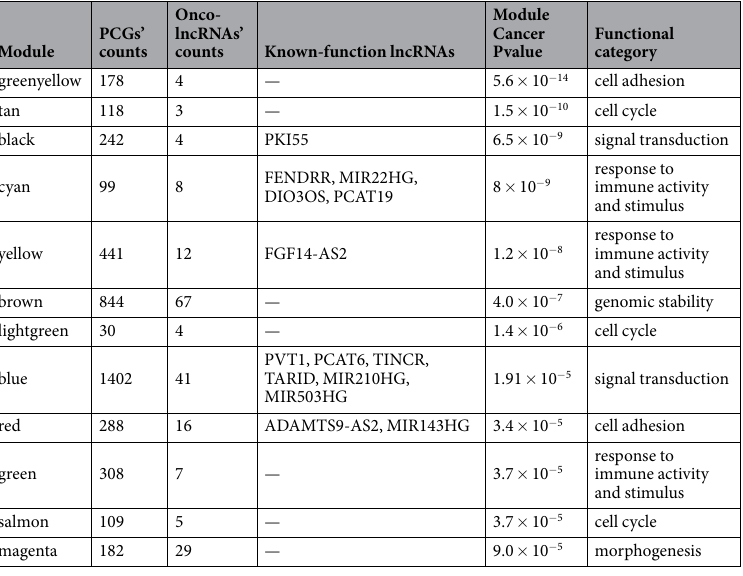
varies between 0 and 67 (Supplementary Fig. S2 and Supplementary Table S4). We took the first principal com- ponent as a module eigengene and used it to represent the overall expression profile of a module 18 , as shown in Supplementary Fig. S3. We obtained the variation of the eigengene between the normal tissues and the tumor ones by one-way analysis of variance (ANOVA) with FDR corrected p-value. The p-value cutoff was set to be 0.0001. Consequently, 12 modules containing the onco-lncRNAs were selected for downstream analysis. The details of the 12 modules are listed in Table 1. To further determine the biological functions of the onco-lncRNAs in the 12 modules, DAVID 32 was used to mine the modules’ biological significance including GO biological process (BP) terms and KEGG pathways. Supplementary Table S8 lists all significantly enriched GO BP terms (p ≤ 0.05) for each module. Figure 4 displays